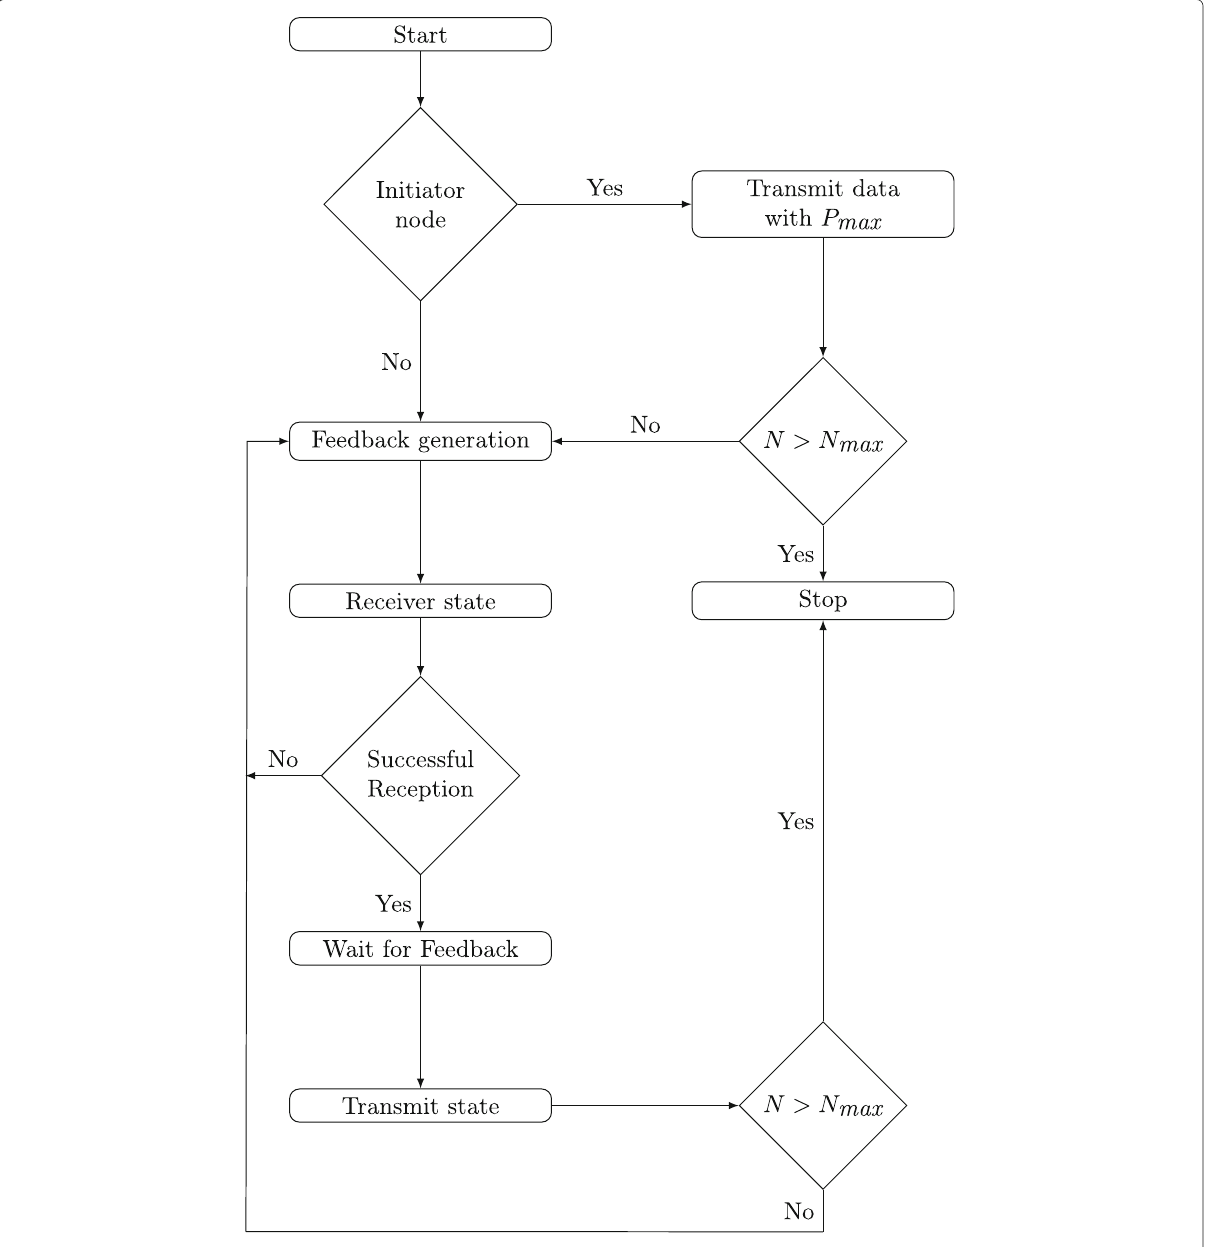
Fig. 4 Protocol operation. Commands executed at any node during the proposed protocol